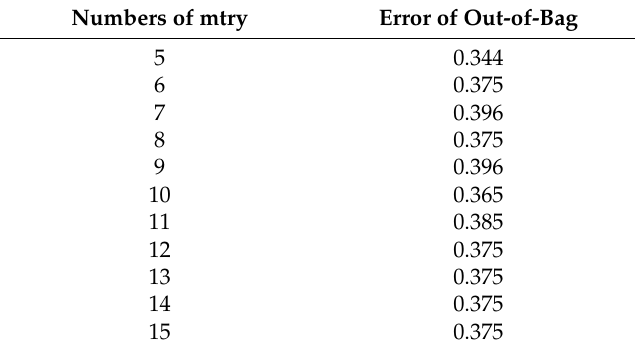
Table 3. Error of out-of-bag.